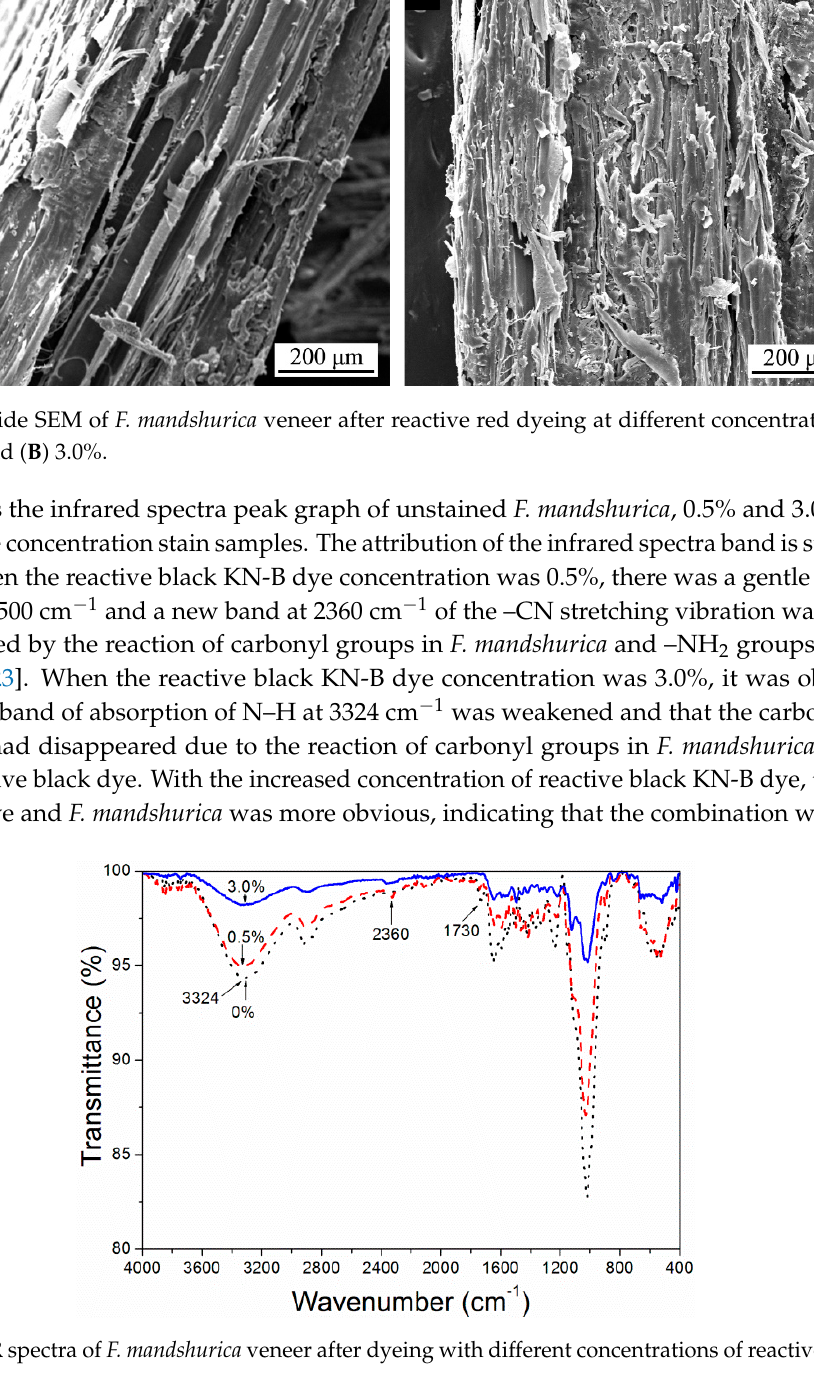
Figure 7. IR spectra of F. mandshurica veneer after dyeing with different concentrations of reactive blue.